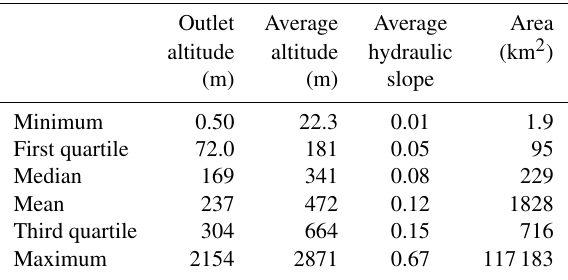
Table 2. Geographic characteristics of the catchment